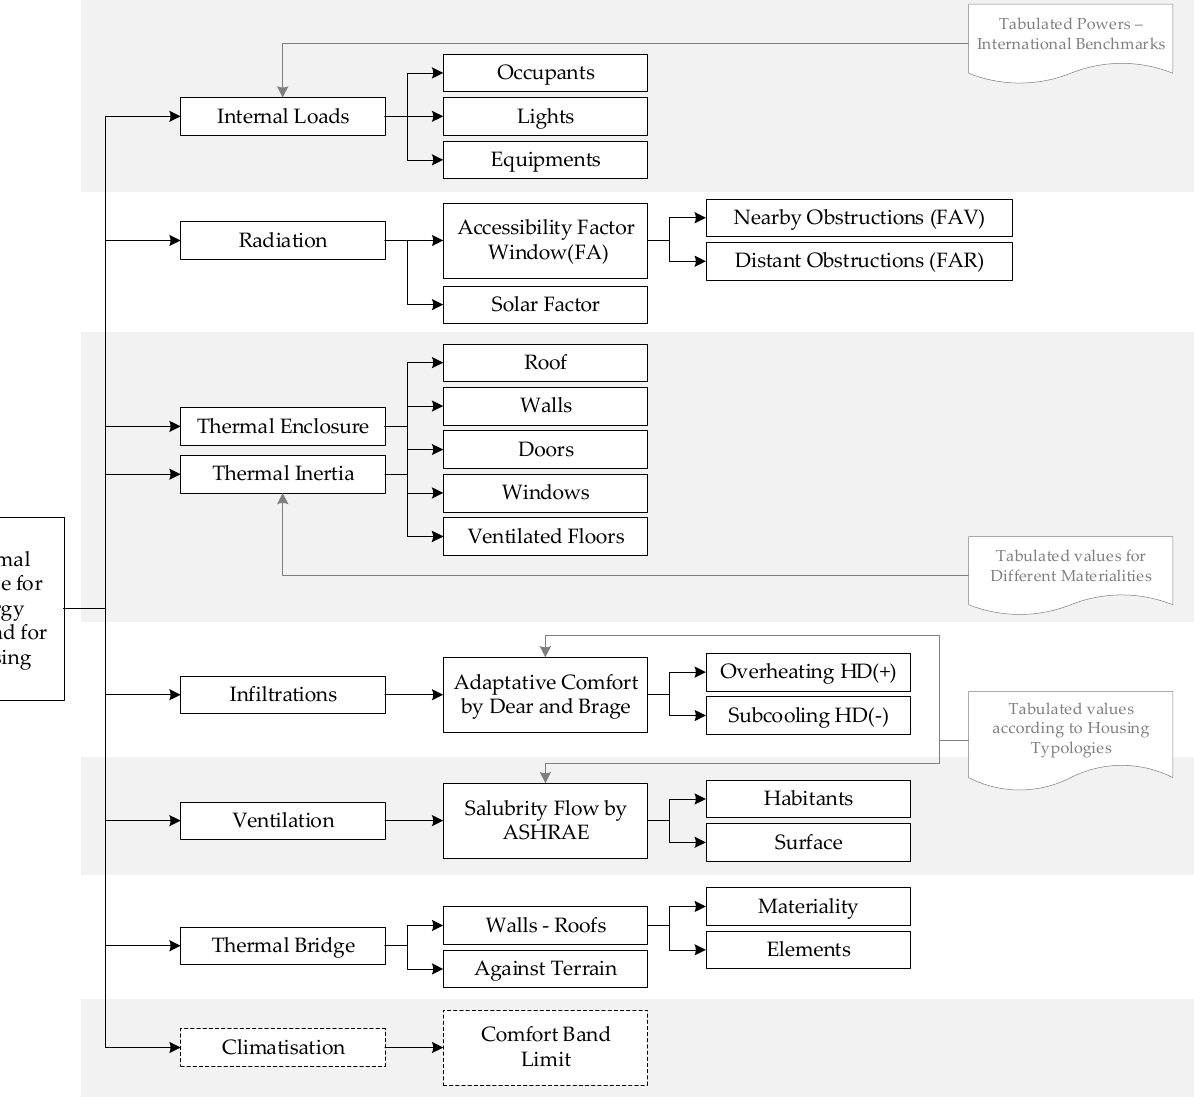
Figure 4. Overview of the factors that influence the calculation of the temperature balance.